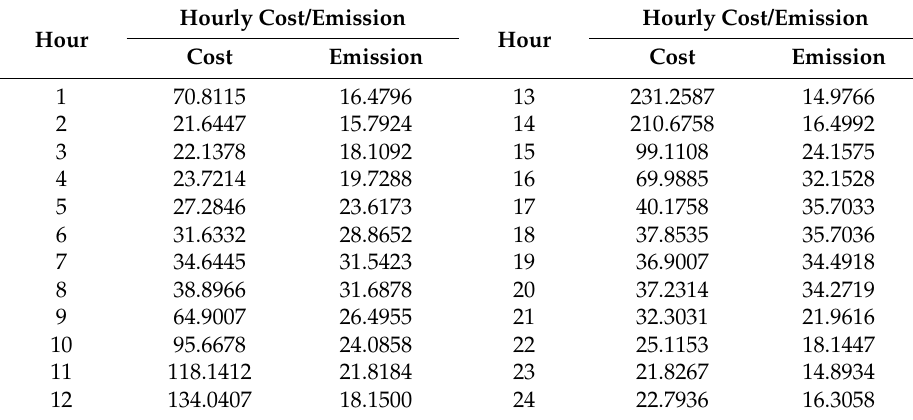
Table 8. Total system cost and generated emission in each